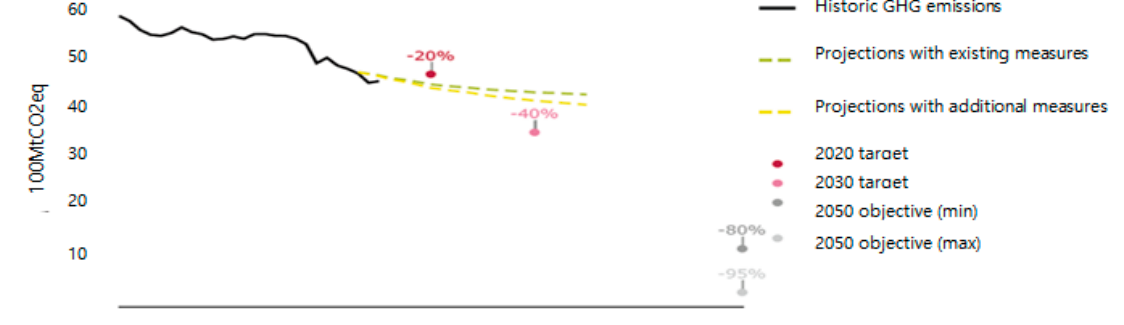
Figure 1. Greenhouse gas (GHG) emission trends in the European Union (EU). Source: European Environment Agency (EEA); Available online: https://www.eea.europa.eu/ (accessed on 27 April 2017).